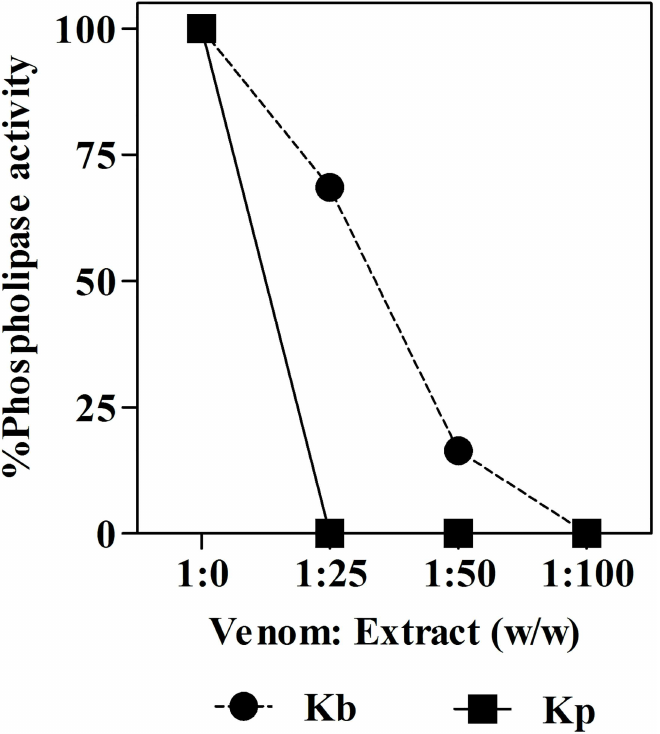
Fig 2. Inhibition of PLA 2 activity of B . jararaca venom by a hydroethanolic extract from K . brasiliensis (Kb) (A) and K . pinnata (Kp) (B). The points are the mean ± SEM (n = 3). Note that the error bars are smaller than the